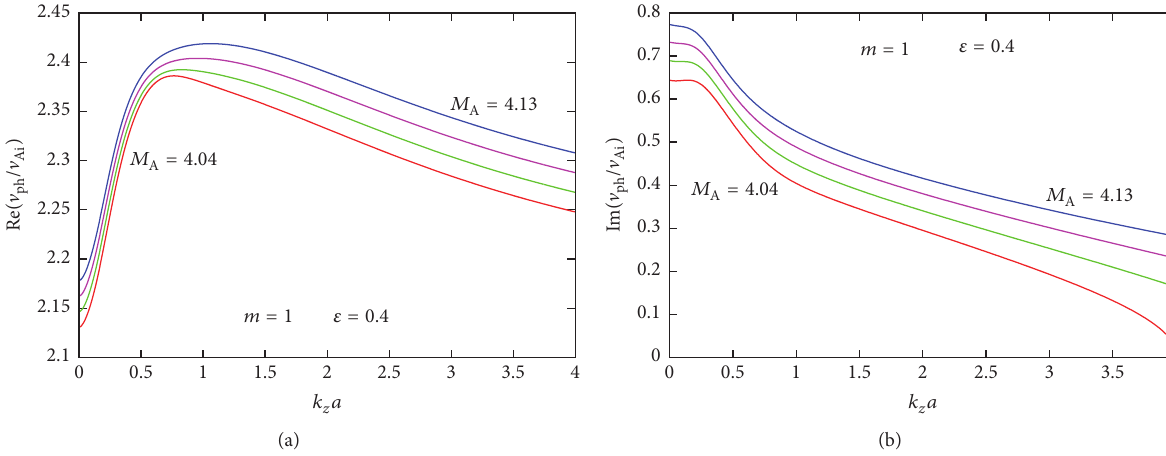
Figure 8: (a) Dispersion curves of unstable ( 𝑚 = 1 ) MHD mode propagating in a moving twisted flux tube of incompressible plasma (modeling jet #11) at 𝜂 = 0.896 and 𝜀 = 0.4 and for 𝑀 A = 4.04 , 4.07 (green curve), 4.1 (purple curve), and 4.13. (b) The normalized growth rates for the same values of 𝑀 A .